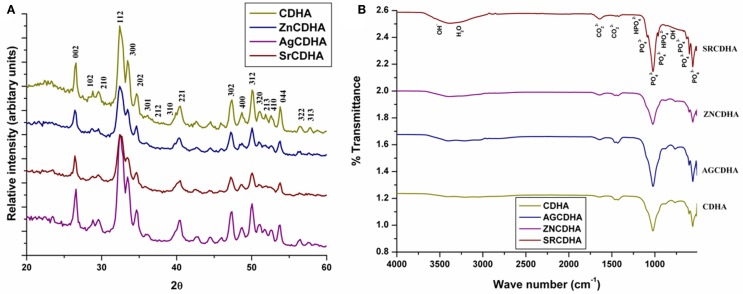
Typical XRD spectra of CDHA and various ion substituted CDHAs (A). Typical FT-IR spectra of pure and ion substituted CDHAs (B).